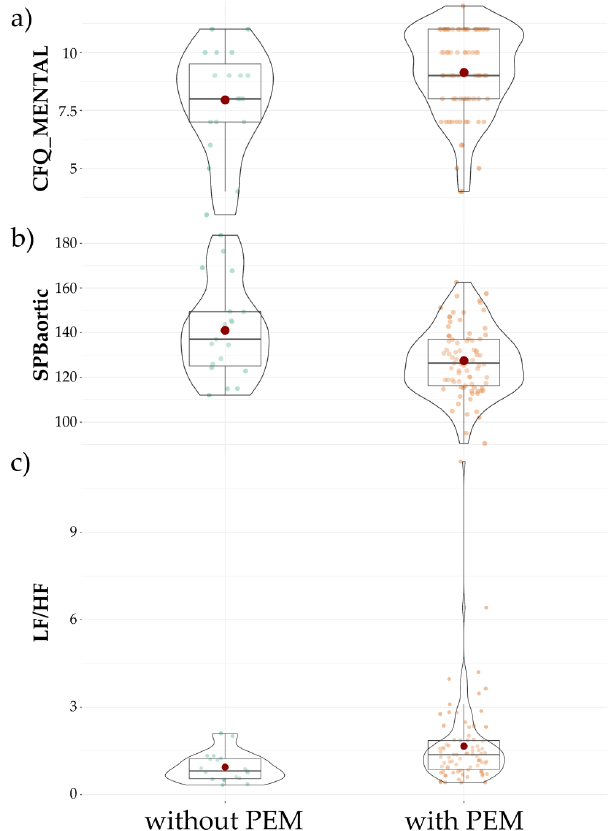
Figure 1. Comparison of patients with PEM vs. without PEM in the CFQ mental fatigue sub-score ( a ), aortic sBP ( b ) and sympathovagal balance ( c ). Red dots indicate mean value, horizontal black line inside the box denotes median value. Green dots before and orange dots after denote results of individual patients. Shape of violin graph indicates distribution of results .